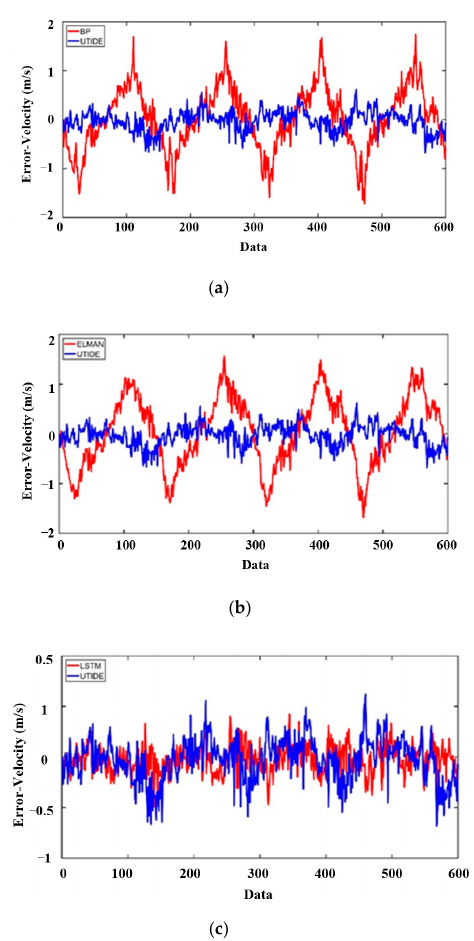
Figure 9. Enlarged figure of the comparison results in Figure 8.